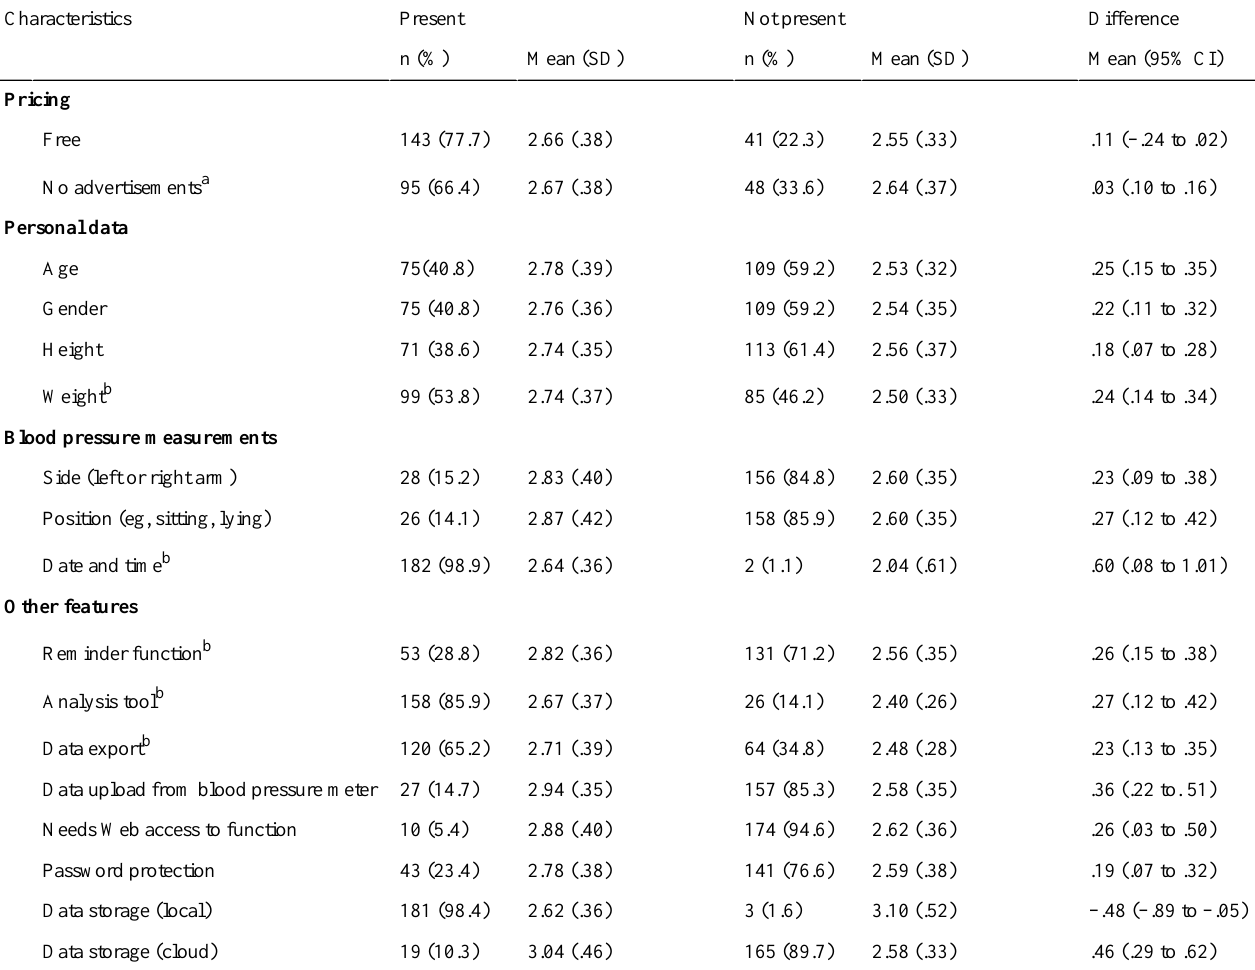
Table 3. Quality scores comparison of apps with and without a specific